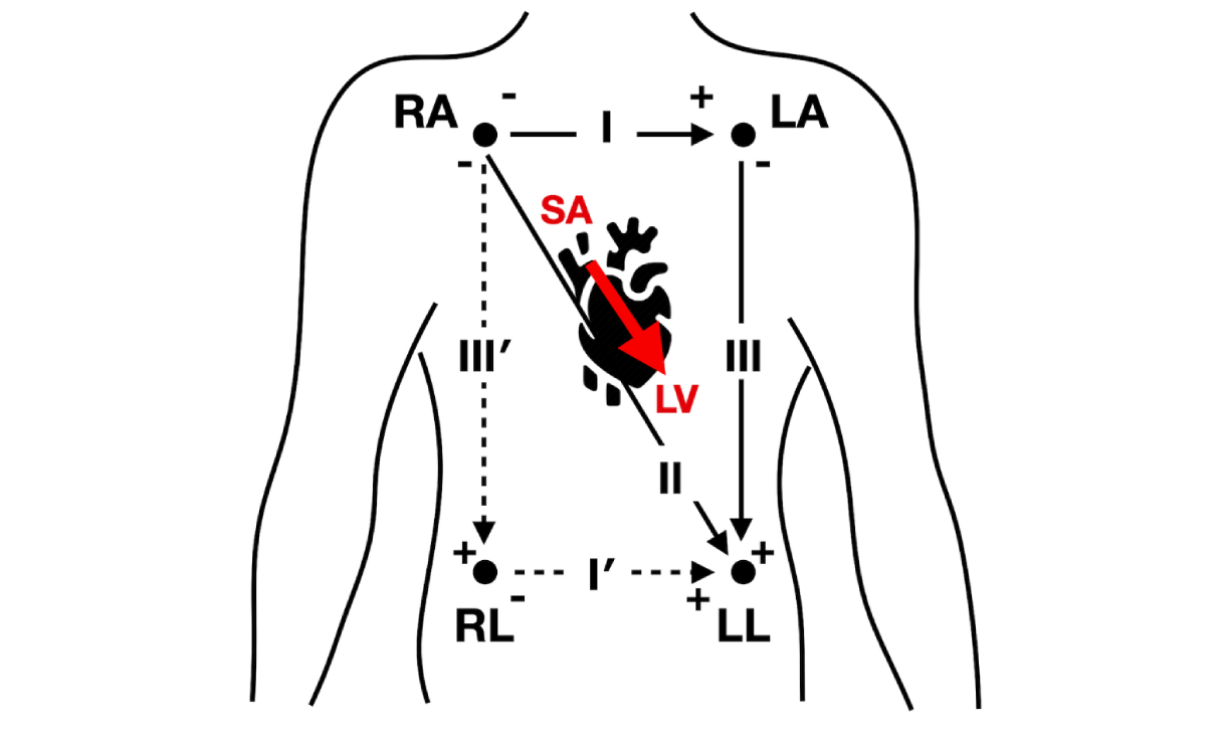
Figure 1. Modified limb leads (I, II, and III). LA: left arm; LL: left leg; LV: left ventricle; RA: right arm; RL: right leg; SA: